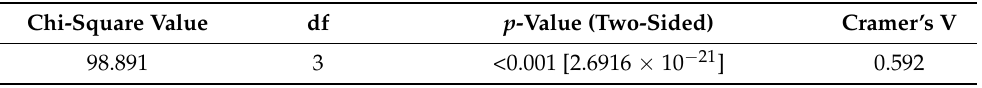
Table A1. Chi-square-test-related statistics of the crosstabulation of the attitude towards the Piresian vaccine with the objective measurement of vaccine